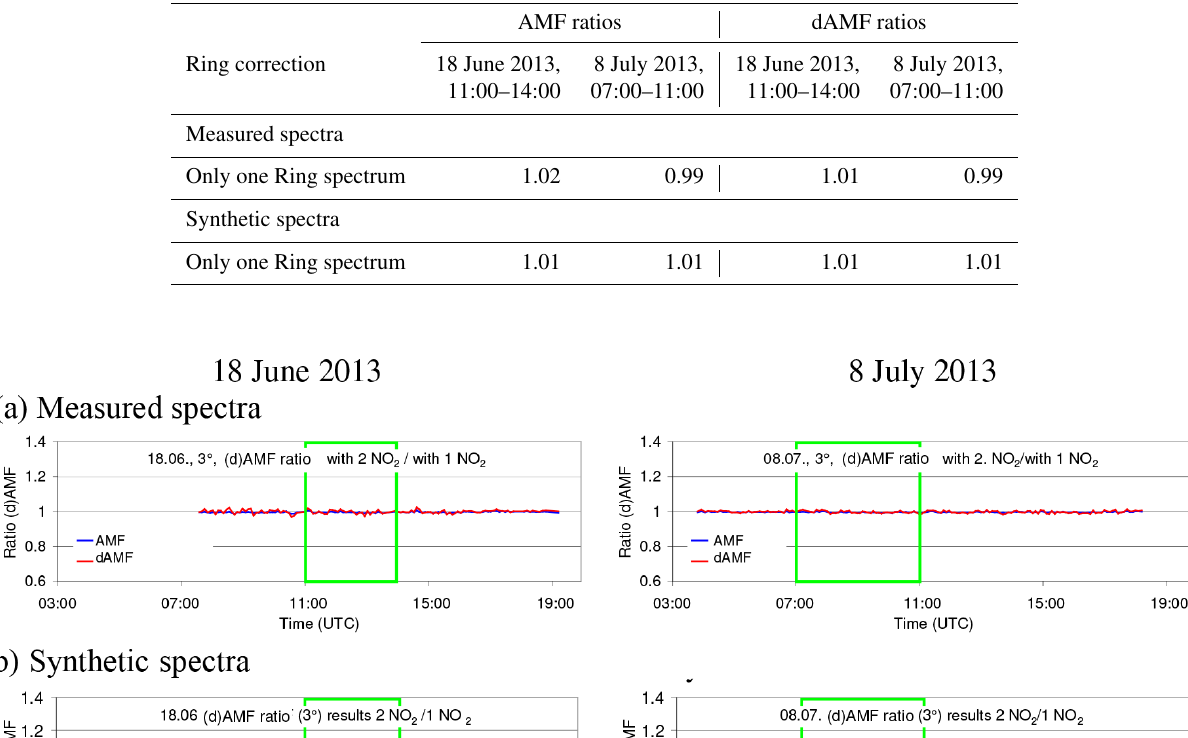
Table A17. Average ratios of O 4 (d)AMFs derived for the analysis with only one Ring spectrum vs. those for the standard analysis (using two Ring spectra) for the middle period on each selected day (top: results for spectra measured by the MPIC instrument; bottom: results for synthetic spectra when taking into account the temperature dependence of the O 4 cross section).